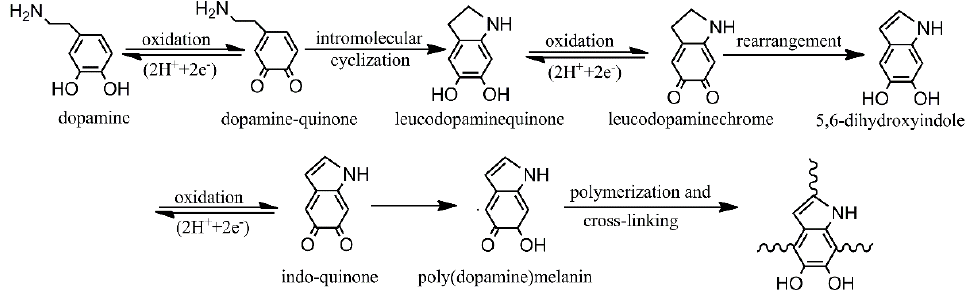
Figure 4. Potential polymerization mechanism of dopamine [32].